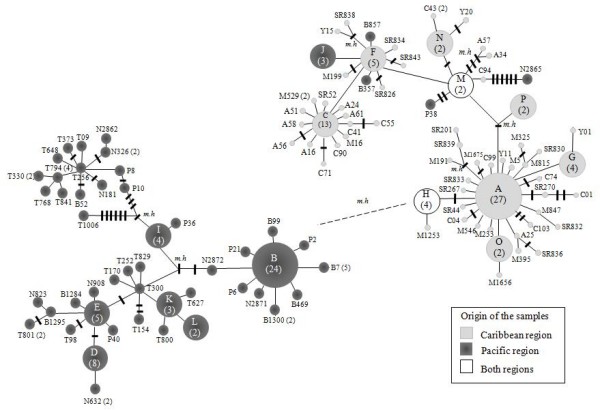
Parsimony-based haplotype networks of 112 haplotypes from 1058 bp of the COI gene sequenced from 220 specimens of An. albimanus. The color of the circles and numbers in parentheses depict the origin and frequency of each haplotype, respectively. Each black bar represents one mutational step; the dashed line and m.h represent missing haplotypes. Unique haplotypes from Caribbean populations are represented in the network as Los Achiotes (A), Santa Rosa de Lima (SR), Moñitos (M) and Turbo (Y and C), and haplotypes from Pacific populations as Nuquí (N), Pizarro (P), Buenaventura (B) and Tumaco (T).